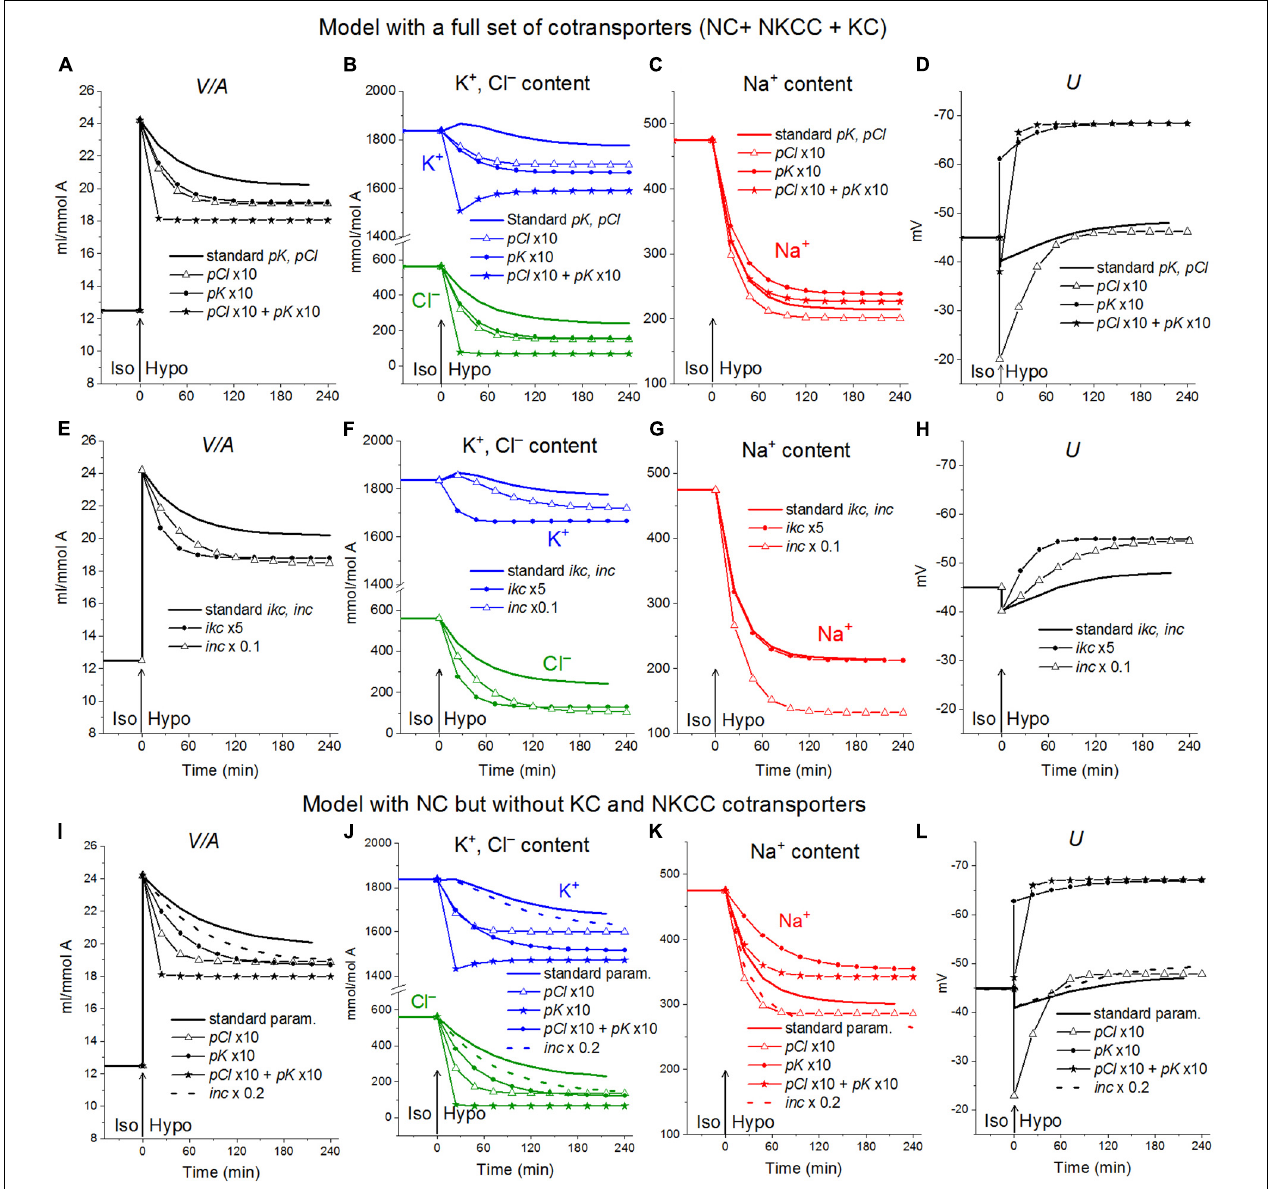
FIGURE 8 | The effect of pK, pCl, NC, and KC rate constant on the rearrangement of ionic homeostasis in the Iso-Hypo transition, calculated for the U937 cell model with a full set of cotransporters and for the model with only NC. The parameters of membrane transport changed simultaneously with the transition to a hypotonic medium. Changes in one of the parameters are indicated on the graphs. The rest of the parameters remain